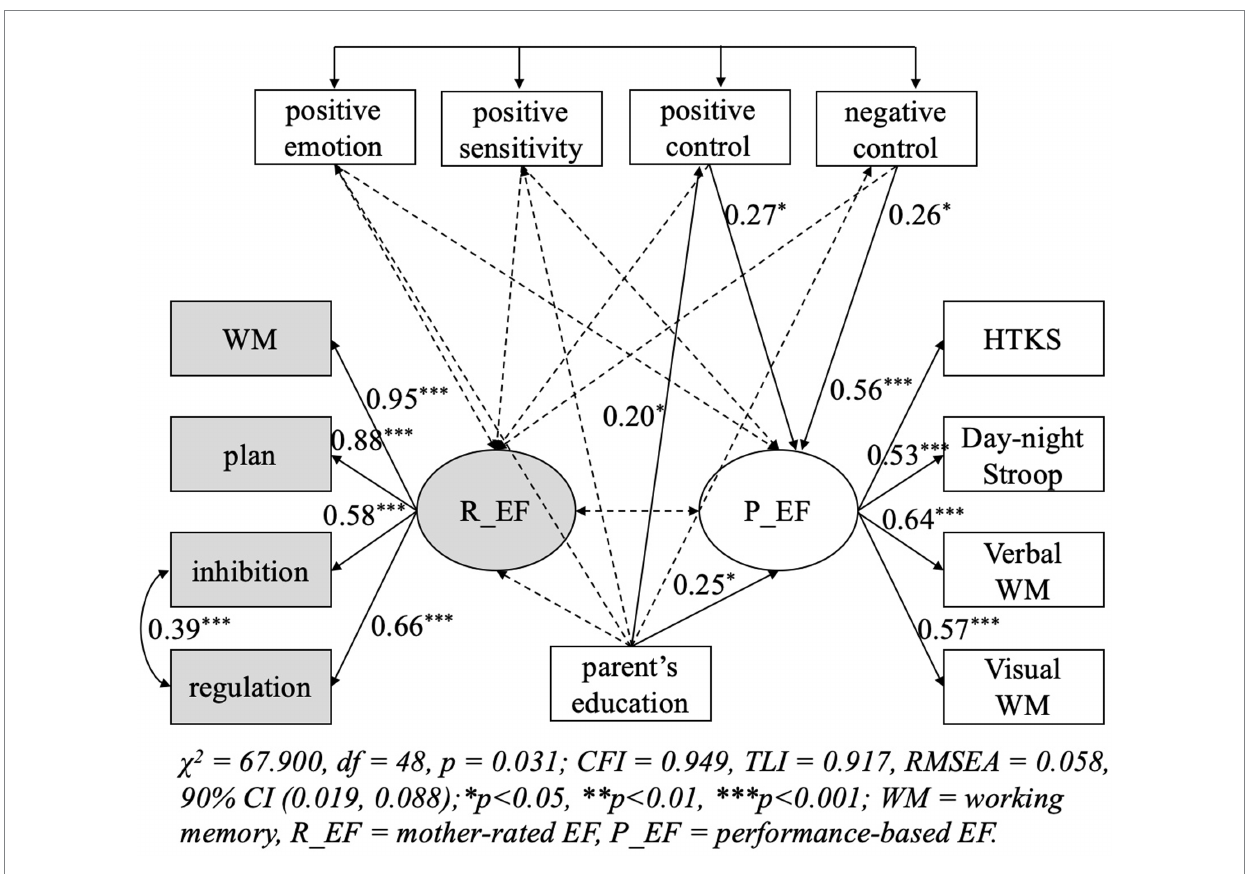
FIGURE 1 Predicting children’s executive functions from observational maternal